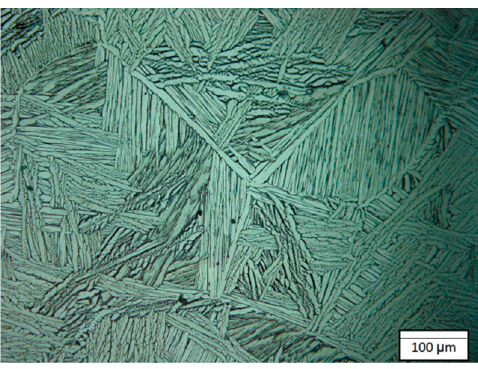
Figure 4. Optical micrograph of the Ti-6Al-4V alloy with Widmanstätten microstructure.